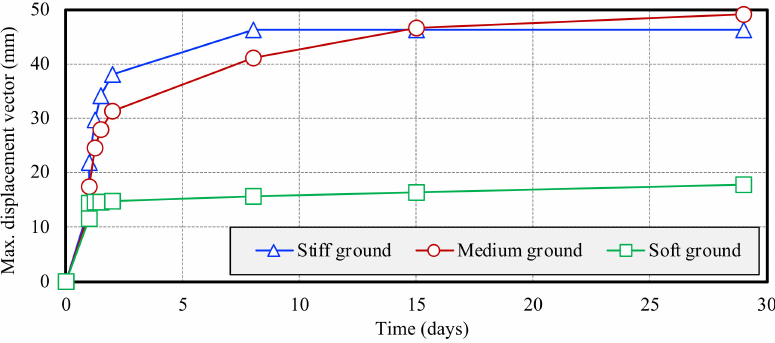
Figure 5. Rates of change in maximum displacement vectors for double boreholes left vacant.